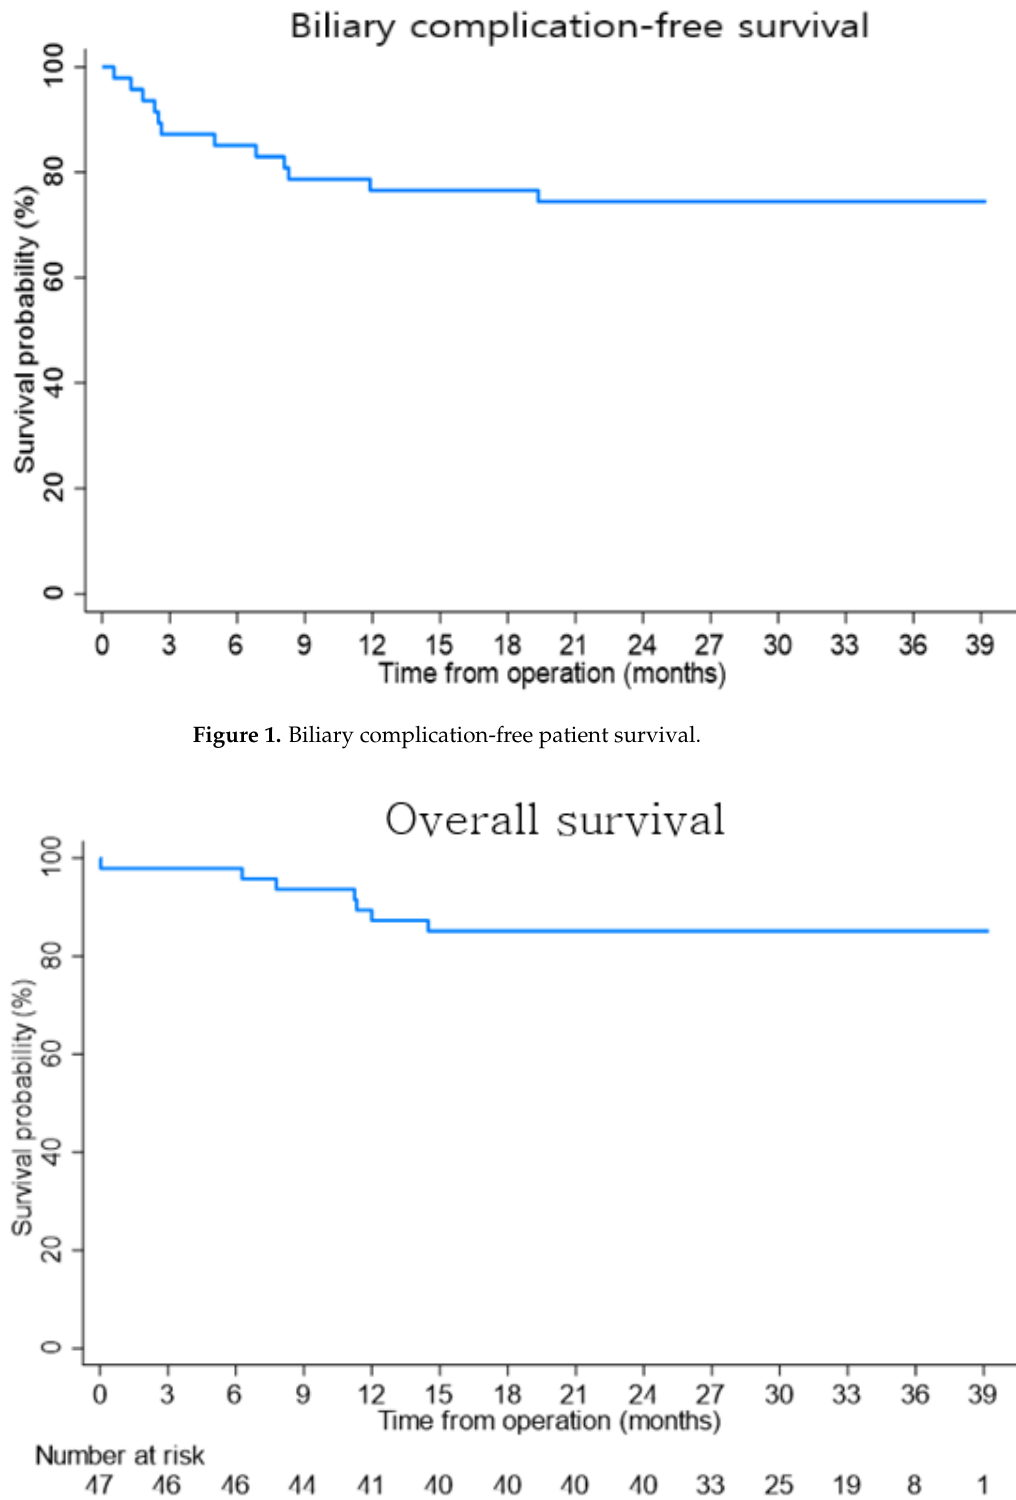
Figure 2. Overall patient